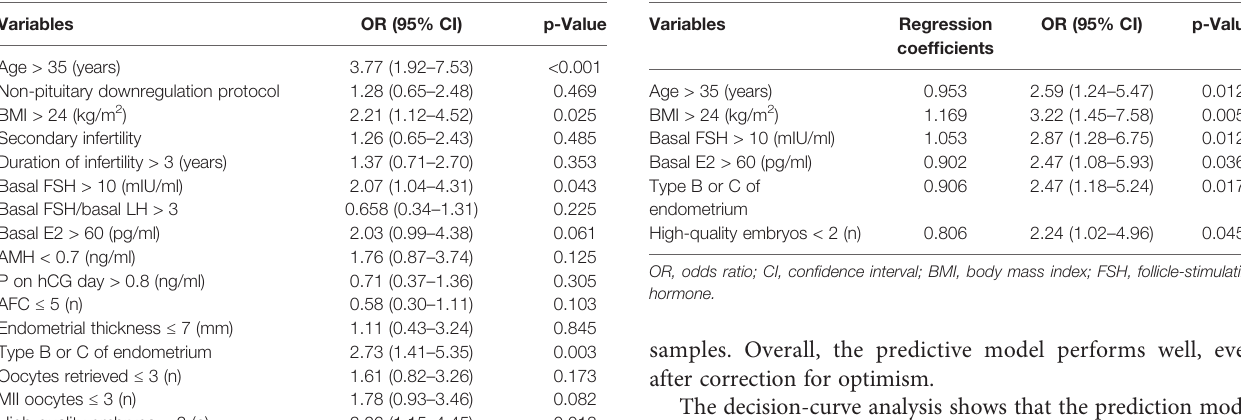
TABLE 2 | Univariate analysis in the training group. TABLE 3 | Multivariate logistic regression model in the training